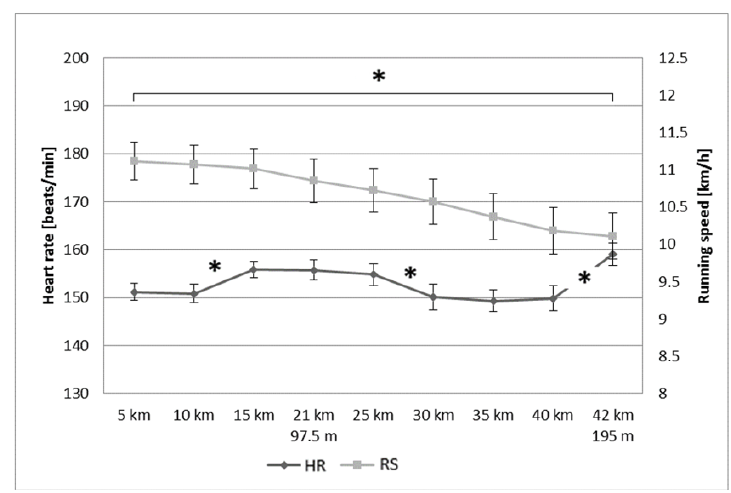
Figure 3. Changes in heart rate (beats / min) and running speed (km / h) during a marathon (mean ± SE). Statistically significant differences: * ( p < 0.05).